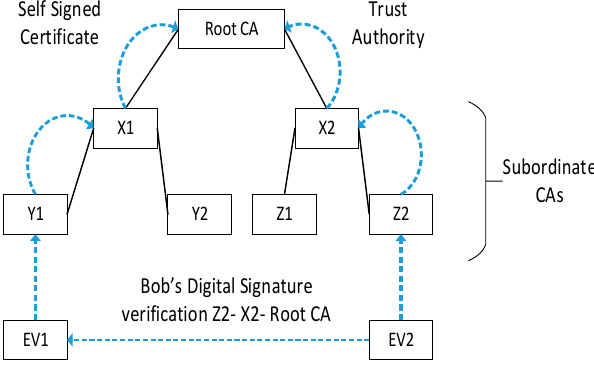
Figure 6. Digital certificate hierarchy for verification.